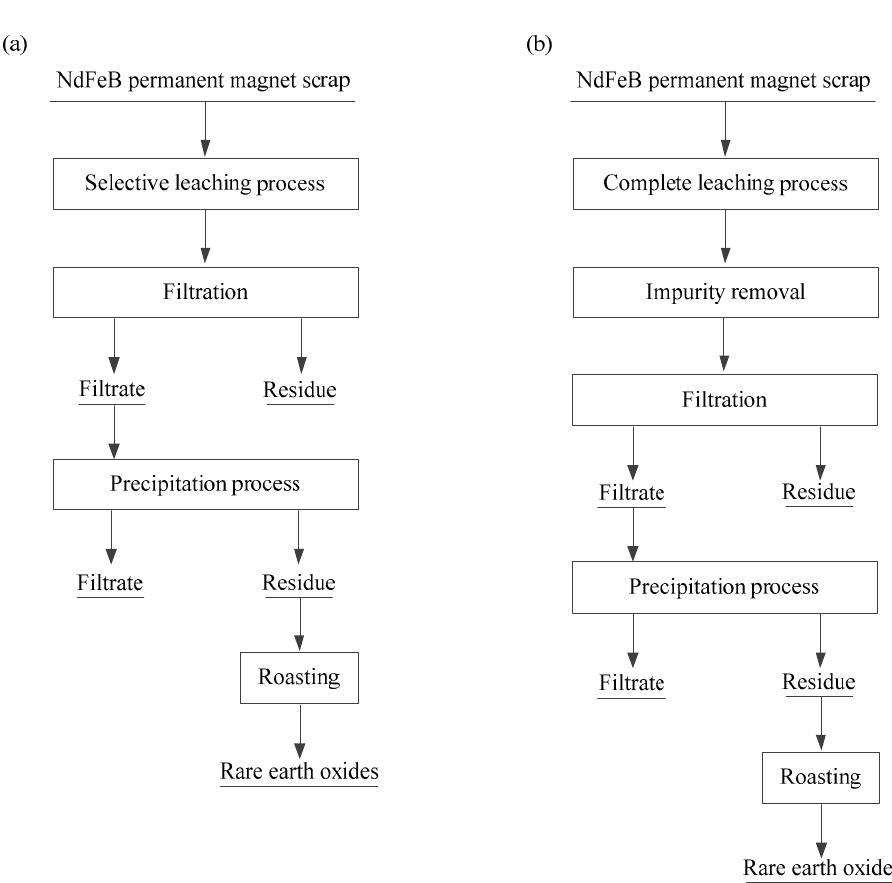
Figure 13. Principle flow of precipitation processes. ( a ) selective precipitation ( b ) co-precipitation